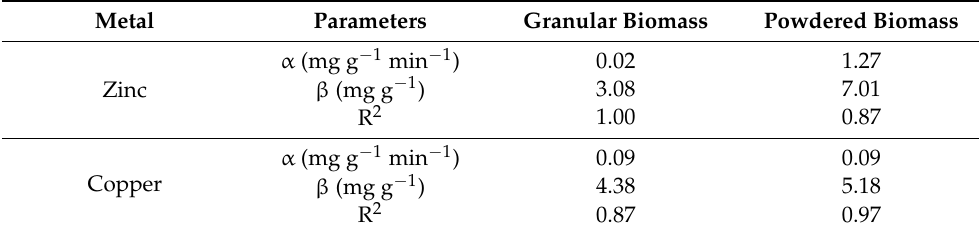
Table 5. Parameters of the Elovich kinetic